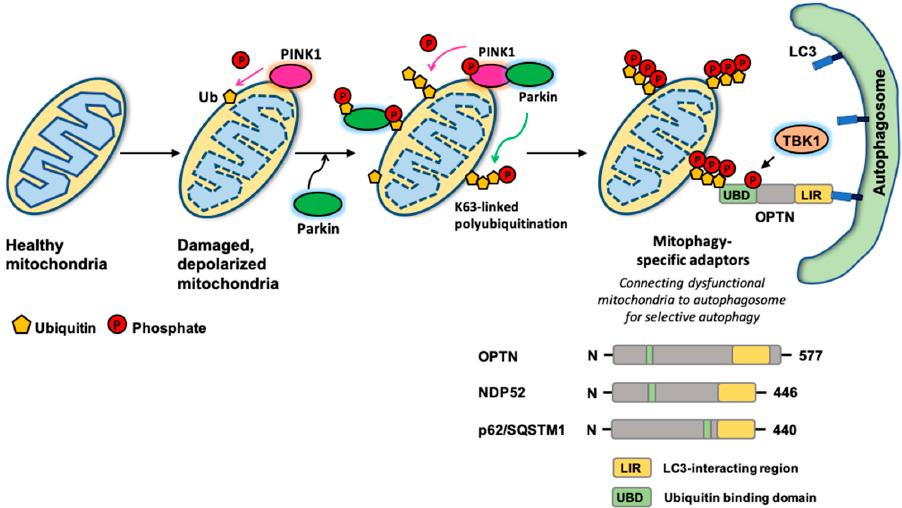
Figure 2. A schematic diagram of the selective autophagy for mitochondria, PINK1-Parkin dependent mitophagy. As a central place dictating cell survival and death, the clearance of damaged mitochondria by autophagy (mitophagy) is particularly important. Here, the PINK1-Parkin mediated ubiquitin-dependent pathway is introduced. In response to mitochondrial damage by depolarizing mitochondrial potential, PINK1 is no longer processed by a set of mitochondrial protease systems, and PINK1 is stabilized to accumulate on the mitochondria. And then, PINK1 recruits and activates Parkin by phosphorylating both ubiquitin and Parkin. Activated Parkin on mitochondria poly-ubiquitinates (mostly, Lys63-linked chain) myriad proteins on the damaged mitochondria. Mitophagy adaptors such as OPTN, NDP52, and p62/SQSTM1 function as a bridge between these poly-ubiquitin chains on the damaged mitochondria (via their UBD domain) and LC3 on the autophagosome (via their LIR motif). TBK1 is a protein kinase activated by mitochondrial damage, and phosphorylates the mitophagy adaptor OPTN to increase the binding affinity between OPTN and poly-ubiquitin chains on the dysfunctional mitochondria, thereby, accelerating mitophagy. Outer mitochondrial membrane proteins Nix/BNIP3L (NIP3-like protein X), BNIP3 (BCL2 interacting protein 3), and FUNDC1 (FUN14 domain-containing protein 1) are other mitophagy receptors that fine-tune mitochondria populations in response to various stimuli. Nix/BNIP3L and BNIP3 are reported to play an important role in hypoxia-induced mitophagy [88,89]. Levels of BNIP3 and Nix/BNIP3L are transcriptionally up-regulated during hypoxia through hypoxia-inducible factor 1 α (HIF-1 α ) [90]. BNIP3 interacts with LC3 and this interaction is promoted by BNIP3 phosphorylations at Ser17 and Ser24, which are located close to the LIR domain [91]. Both Nix/BNIP3L and BNIP3 also cross-talk with the PINK1-Parkin pathway [92,93]. Nix/BNIP3L